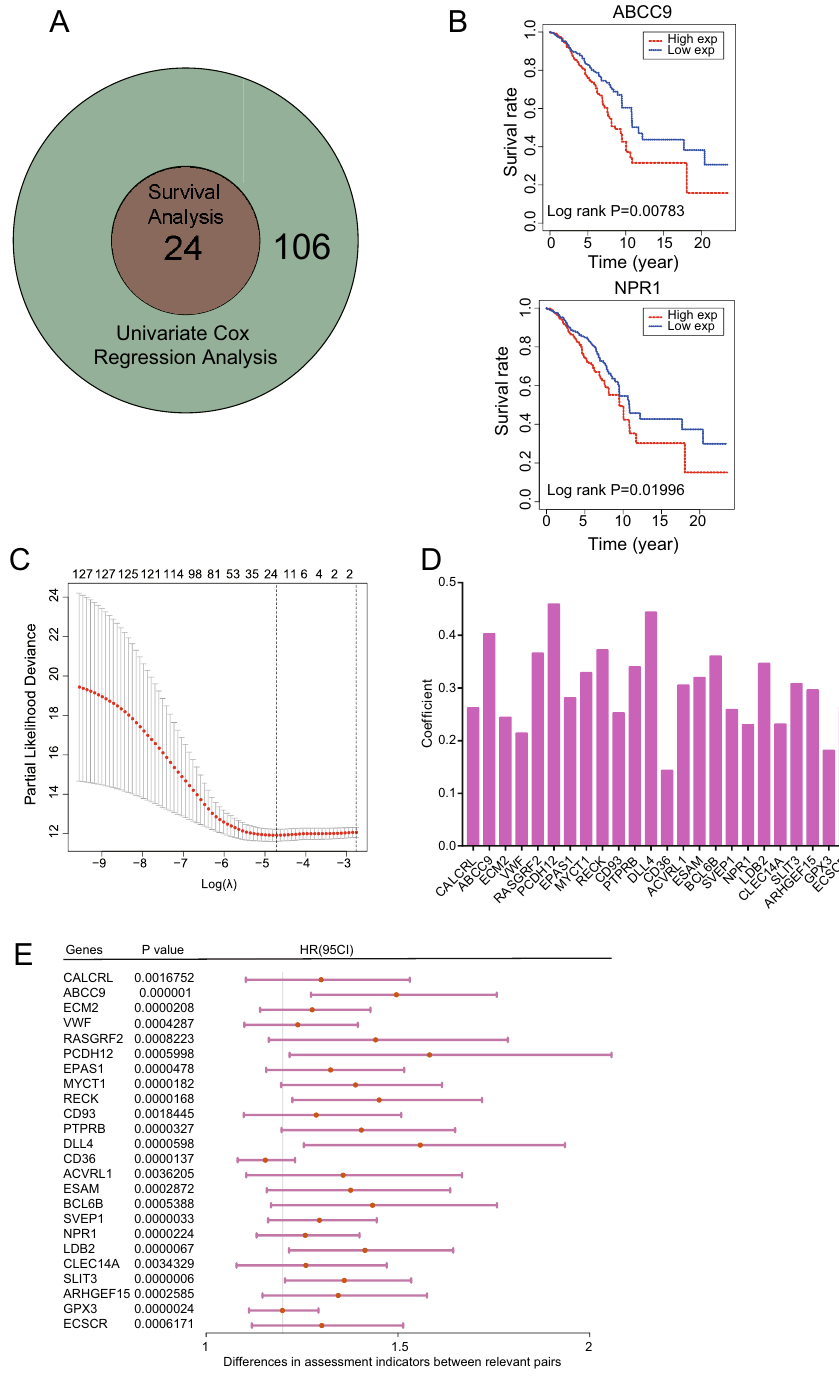
Figure 5. Univariate regression analysis and KM survival analysis of the BLUE module related to breast cancer prognosis. ( A ) Winn plots showing the intersection of significantly different genes in univariate regression analysis and KM population survival analysis. ( B ) KM survival curves of ABCC9 and NPR1. ( C ) Lasso dimensionality reduction analysis of 130 genes with significant differences in univariate analysis. ( D ) Correlation coefficient distribution of 24 intersection genes analyzed by univariate regression. ( E ) Visualization of univariate regression analysis of 24 intersection